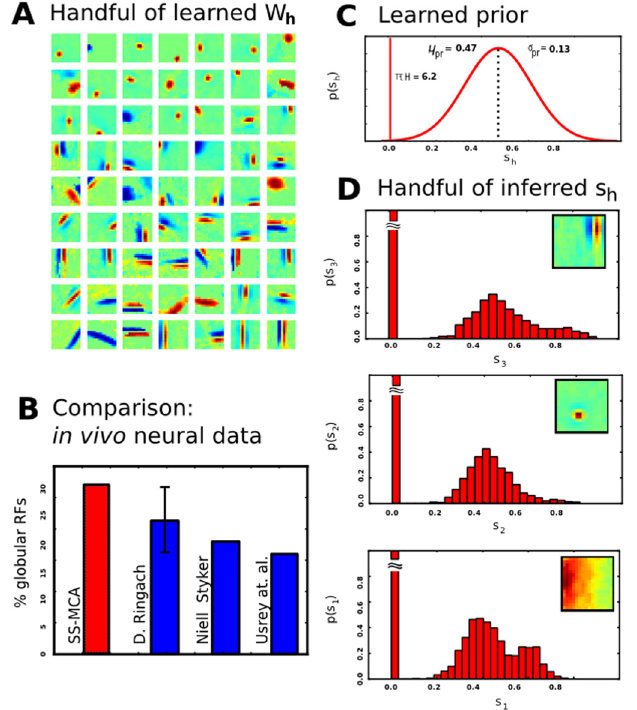
Fig 10. Analysis of dictionary components learned by the SSMCA algorithm on natural image patches. A Example dictionary elements W h after learning. B Fraction of globular fields estimated from in vivo measurements, compared to ours (after fitting with Gabor wavelets and DoG ’ s; globular percentages taken from [19] who analyzed data provided by [18] and estimated percentages of globular fields from data in two further papers [43, 44]. C Learned prior. D Actual activations of diverse dictionary elements s h (posterior averaged over data points).